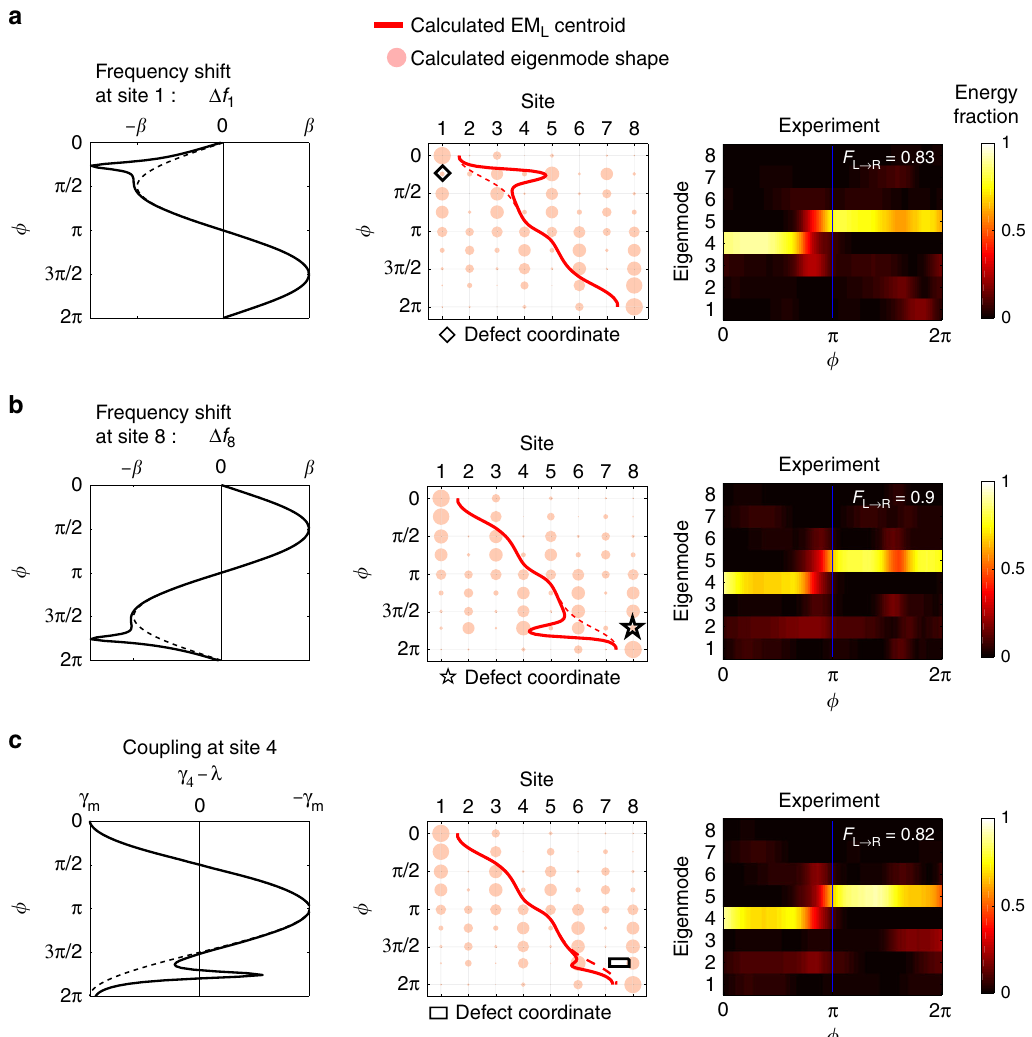
Fig. 5 Implementation of spatio-temporal defects. Since the governing Hamiltonian of the topological pump matches that of a Chern insulator, pumping is robust to defects along its pseudo-edge in space and time. We can use the centroid of the EM L mode to track this pseudo-edge and place defects along its path. a A temporal on-site potential defect is placed at the space (site) and time ( ϕ ) coordinates marked by the diamond symbol. The defect is produced by modifying frequency f 1 away from the prescribed trajectory during the pumping cycle. The experimentally measured modal energy fraction exhibits high fi delity indicating that the pump remains robust. b We repeat the experiment from a with an on-site potential defect at the coordinates indicated by the star symbol. Again, high fi delity pumping is experimentally measured. c We also explored the intrusion of a trivial phase at the boundary of the equivalent 1 + 1D Chern insulator. This is implemented by modifying the intra-cell coupling rate γ 4 at the 4th unit cell, between sites 7 and 8, with space-time coordinates marked by rectangle symbol. Here γ 4 deviates from the prescribed trajectory during the pumping process (inter-cell coupling rate λ remains fi xed). Once again, the experimentally measured modal energy fraction shows high fi delity pumping in spite of the trivial phase